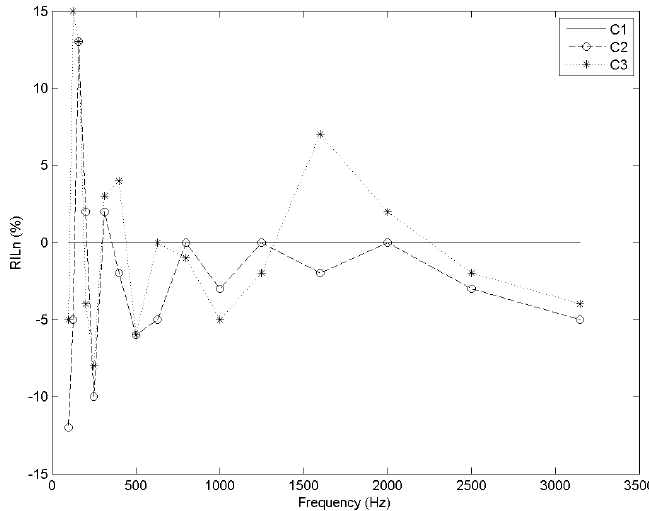
Figure 11. RIL n (%) vs. frequency (Hz) for each cell type. Frequency range 100–500 Hz.